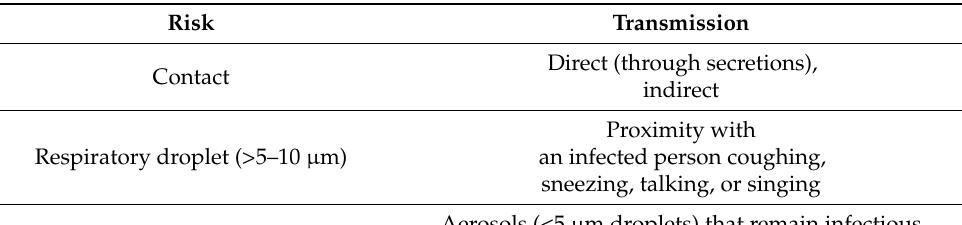
Table 5. SARS-CoV-2 risks of